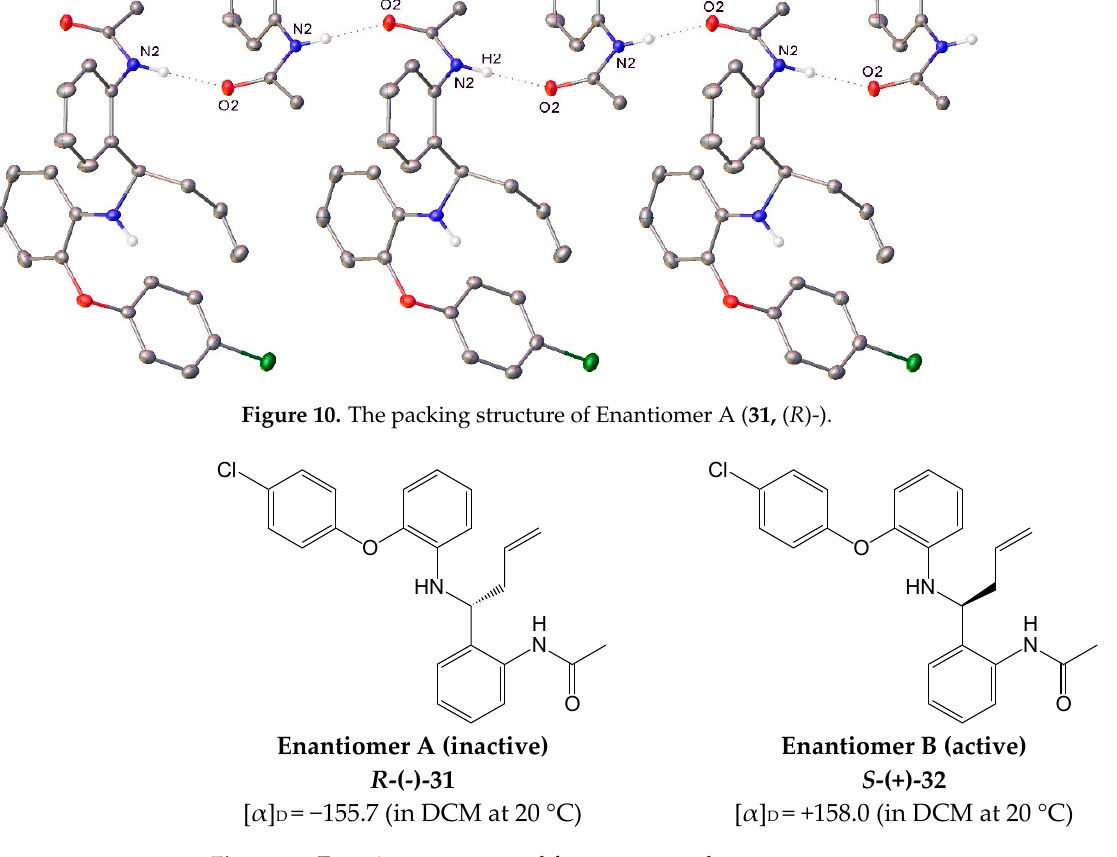
Figure 11. Enantiomers separated from compound 26 .